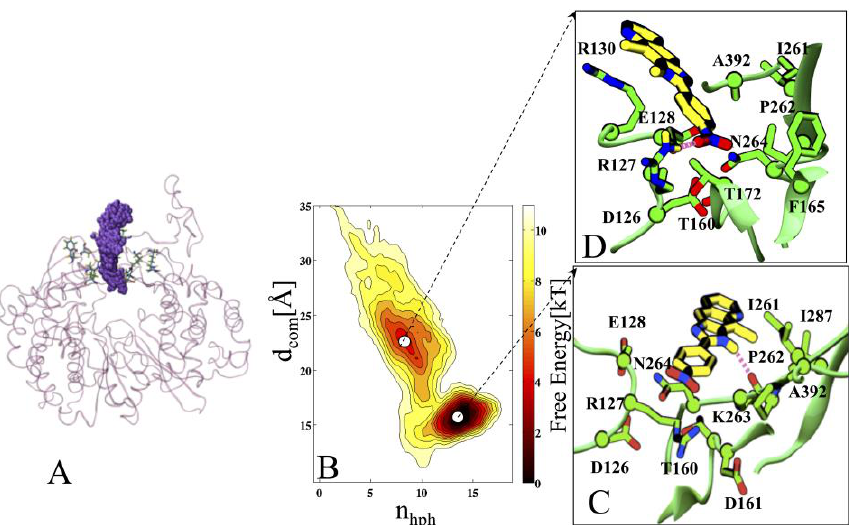
Figure 4. Characterization of 2h unbinding during metadynamics simulation. ( A ) The starting state of 2h. ( B ) the two-dimensional free-energy surface (FES) of 2h in COM1 and its dissection according to the minima obtained during the unbinding process. Each color and each line of FES correspond to 1 kcal/mol. ( C , D ) Conformations representing the different states of 2h in COM1, enlarged from two respective basins (mini-1 and 2). The FES of 2h is ~10 kcal/mol. The free energy is contoured in steps of 2 kcal/mol up to 10 kcal/mol. In panels ( C , D ), the inhibitor 2h is represented in yellow and amino acids are shown in green. The red dotted line represents the HB between residues and 2h.